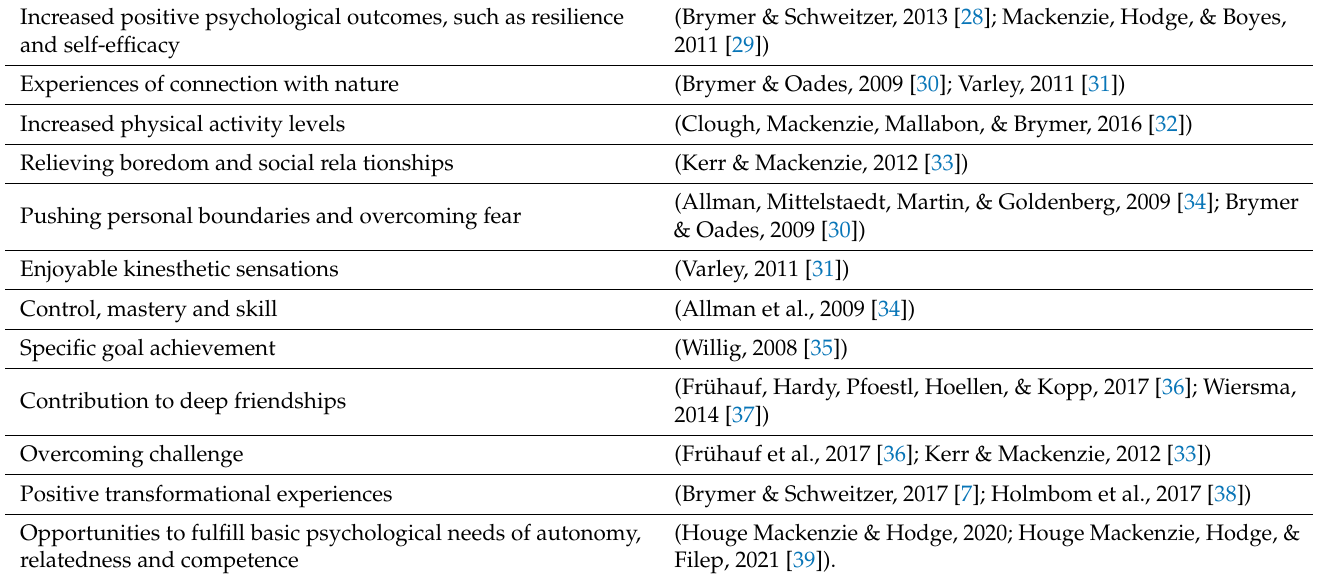
Table 1. Diversity of motives and effects of adventure sport